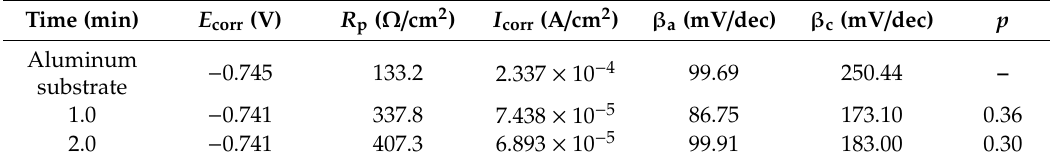
Figure 10. SEM of coating with different drying times: ( A ) 30 s, ( B ) 1.0, ( C ) 2.0, ( D ) 3.0, ( E ) 4.0, ( F ) 5.0, and ( G ) 6.0 min.